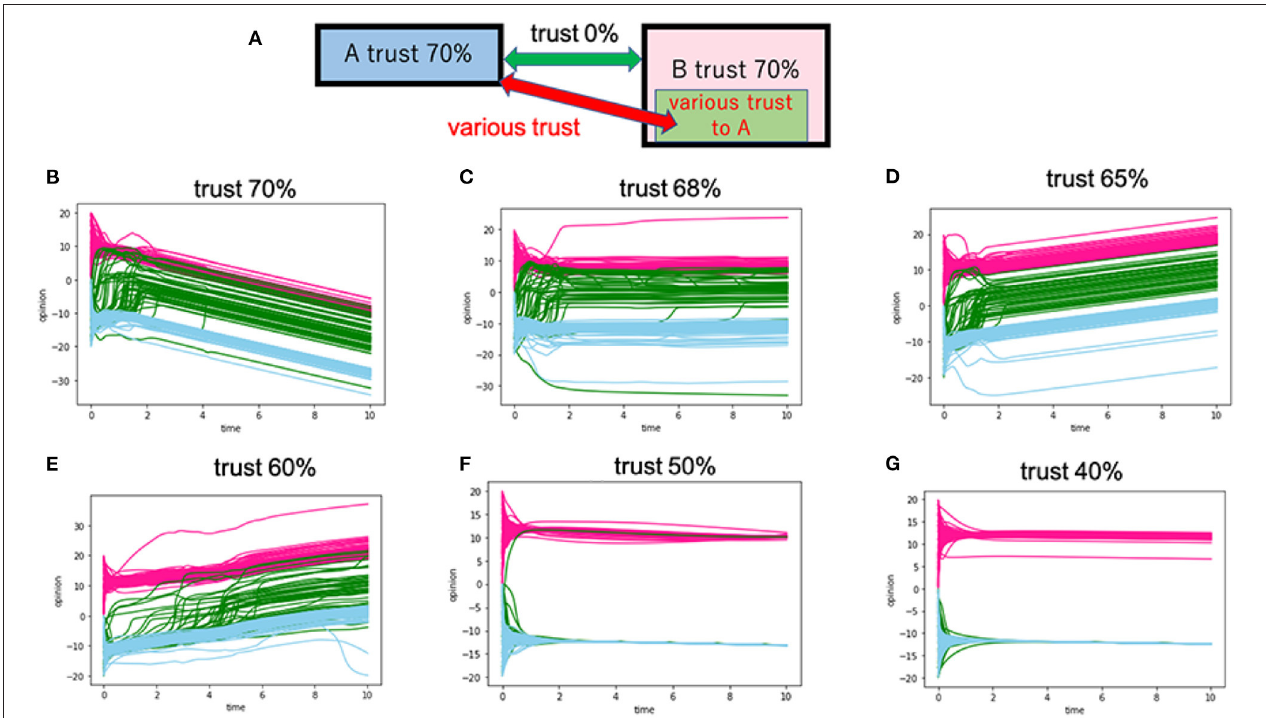
FIGURE 7 | Cases in which no intergroup trust exists between group A and group B. The intragroup trusts for group A and group B are fixed to 70%. Furthermore, 50 people in group B (B-1) have intergroup trust toward group A. (A) Presents this model’s schematic view. (B–G) Correspond to the various intergroup trusts between B-1 and group A. For example, the trust of 70% means that the intergroup trust ( D ij ) between B-1 and group A posits a positive value of 70%. The red lines represent the opinion trajectories of group A. The blue lines show those of group B except for the B-1 subgroup. The green lines are the opinion trajectories of